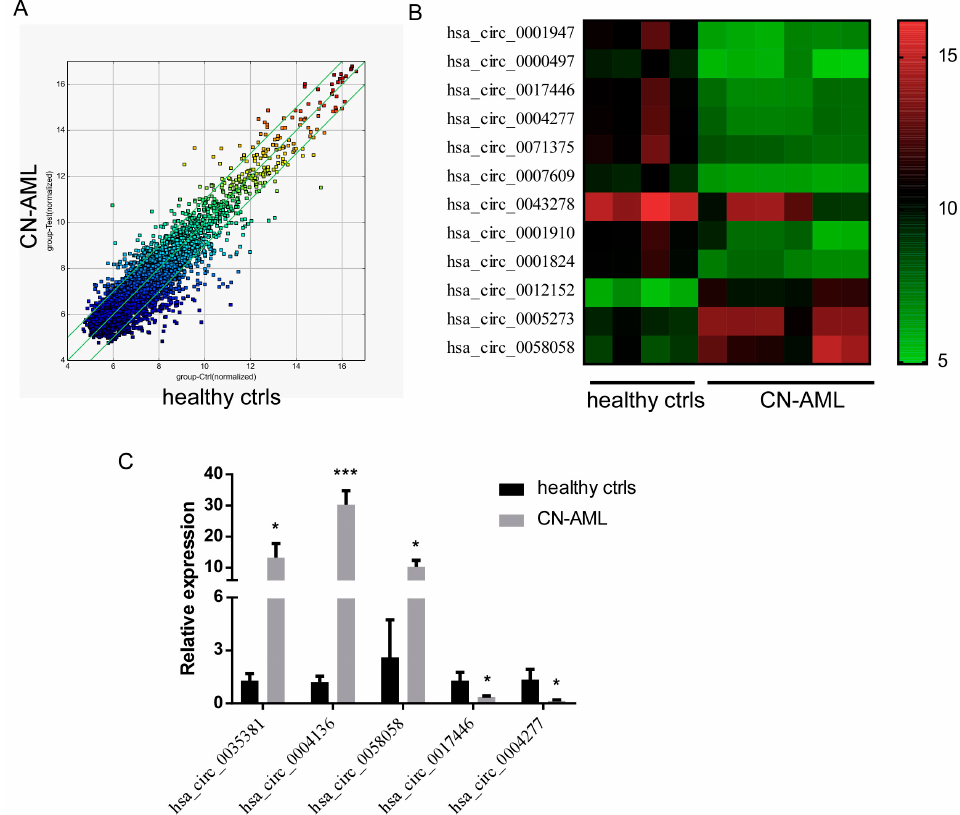
Figure 1. Circular RNA (circRNA) profile in acute myeloid leukemia (AML) and quantitative Real-Time PCR (qRT-PCR) validation. ( A ) Scatter plot showing the expression profile of 4573 circRNAs between the two compared groups. circRNAs above and below the border green line were expressed more than two-fold changes in AML patients than the healthy controls; ( B ) Clustered heatmap for 12 dysregulated circRNAs 10-fold more prevalent than the average of healthy controls; ( C ) Quantitative RT-PCR validation for five circRNAs from the microarray data. * p < 0.05, *** p < 0.001.